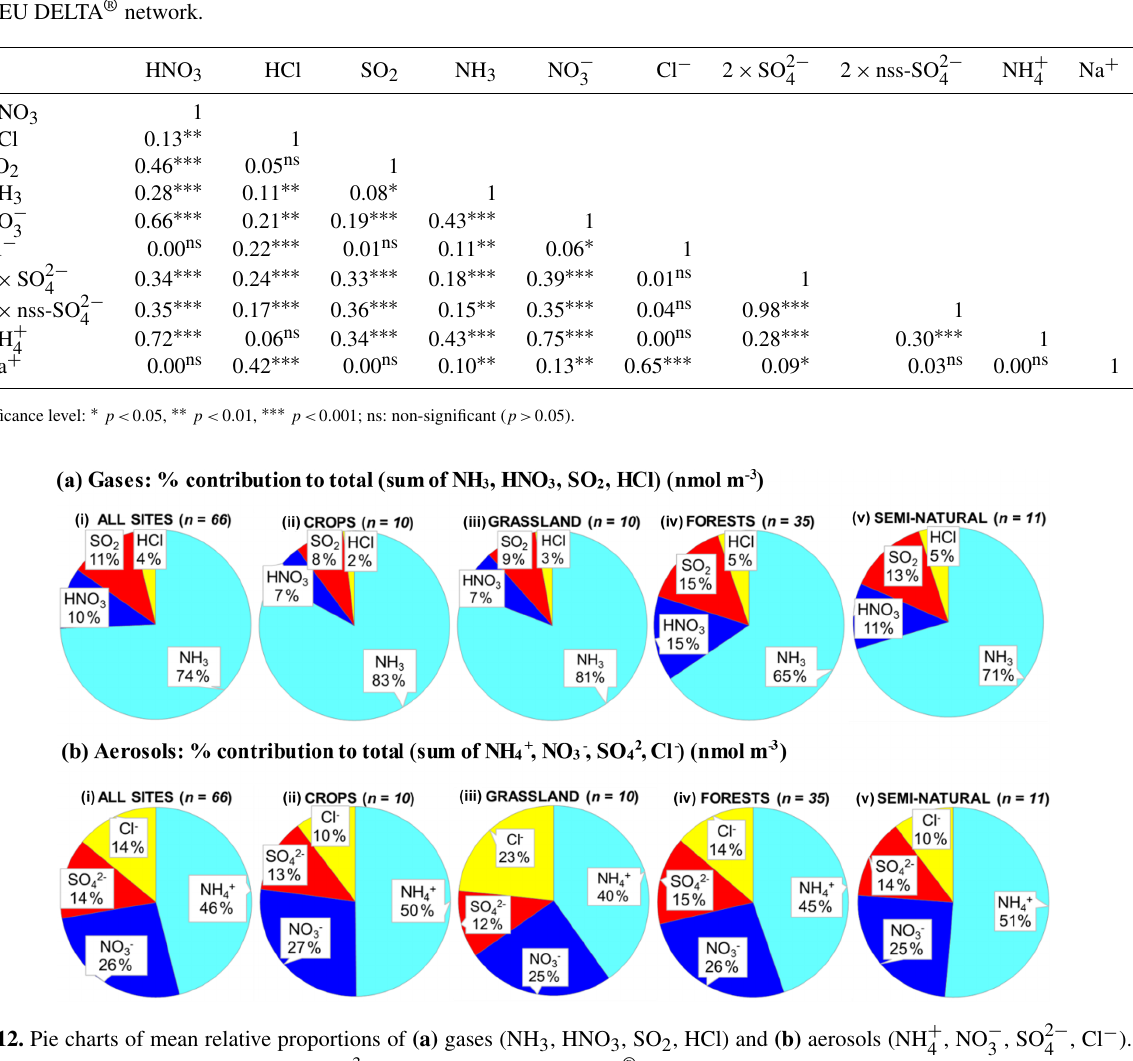
only) and FR-FgsP (parallel DELTA ® at Fougéres: different sample train) were excluded in this 4